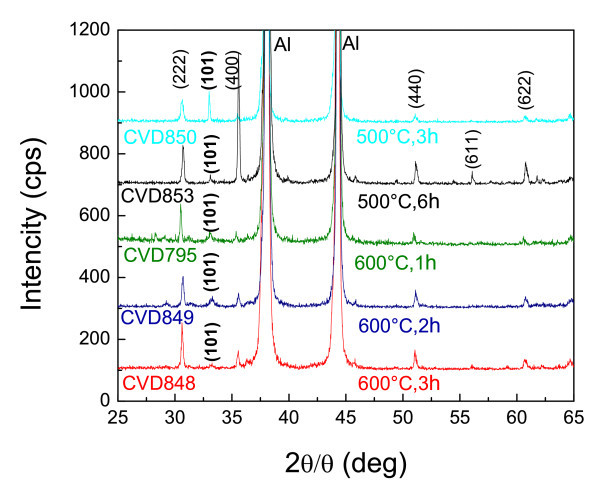
XRD of In2O3 NWs obtained after nitridation at 500 and 600°C for different times as described in Table 1.